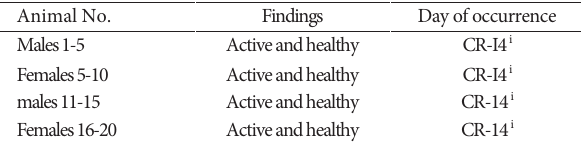
Table 6. Individual cage-side observations Animal No.